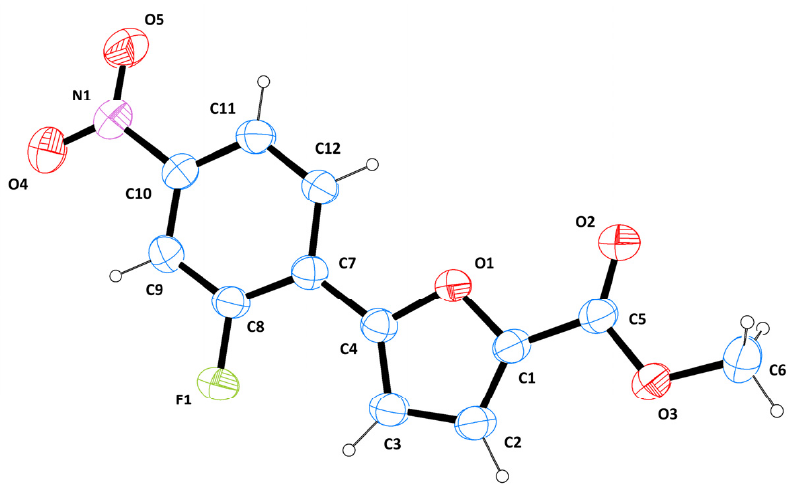
Figure 1. ORTEP diagram of 1 , with the arbitrary atom-numbering scheme. Displacement ellipsoids were drawn at the 40% probability level.